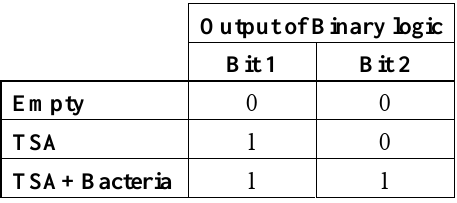
Table 2. The output of the Boolean logic circuit at the different